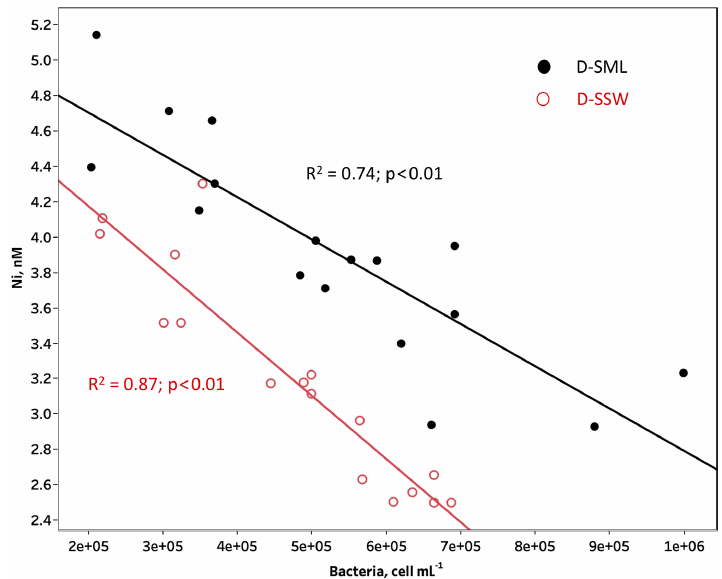
Figure 2. Concentration of dissolved Ni plotted against bacterial abundance in both the surface microlayer (SML, black dots) and subsurface water (SSW, red open dots). The lines represent least-square linear regressions. Table 5. Spearman’s rank correlation coefficients for selected parameters: bacteria; HNA: high-nucleic-acid-content bacteria; LNA: low- nucleic-acid-content bacteria; picophyto: picophytoplankton; transparent exopolymer particles: TEPs; primary production: PP; and chloro- phyll a : Chl a . Significant correlations at p < 0 . 05 and p < 0 . 01 are marked with one asterisk (italic numbers) and two asterisks (bold numbers),